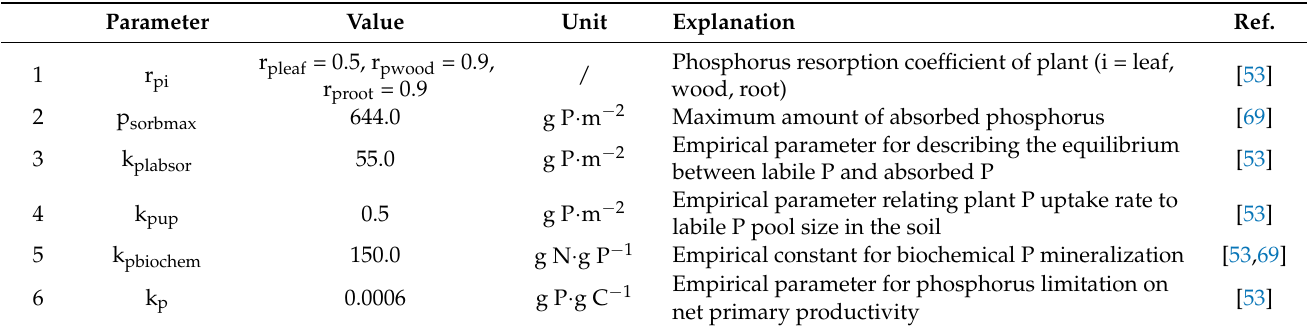
Table 1. List of key parameters and their initial